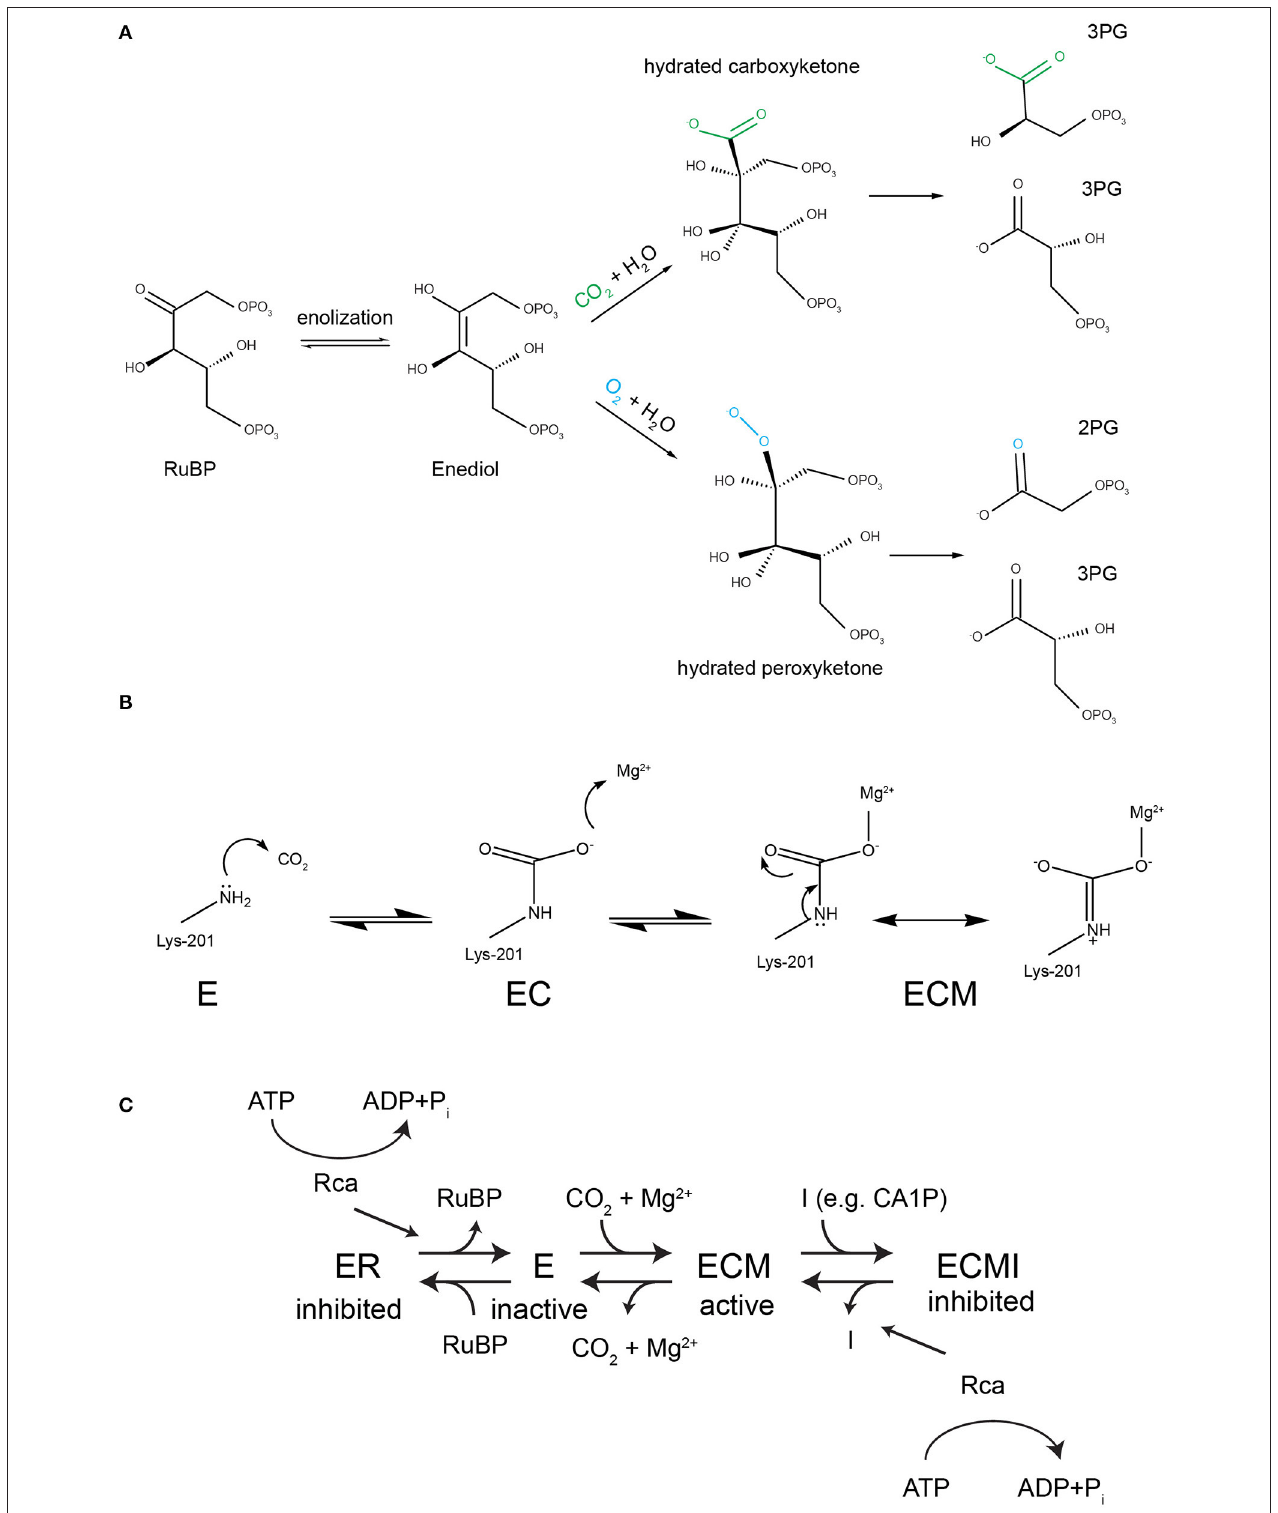
FIGURE 1 | Rubisco’s reaction mechanism and its inhibition properties. (A) A complex conserved reaction mechanism evolved to carboxylate ribulose 1,5-bisphosphate. The enediol intermediate can react with both oxygen and carbon dioxide. If oxygenation occurs the toxic metabolite 2-phosphoglycolate (2PG) is generated, which must be subjected to metabolite repair. (B) To perform the carboxylase reaction a conserved active site lysine (Lys-201 in spinach RbcL) must react